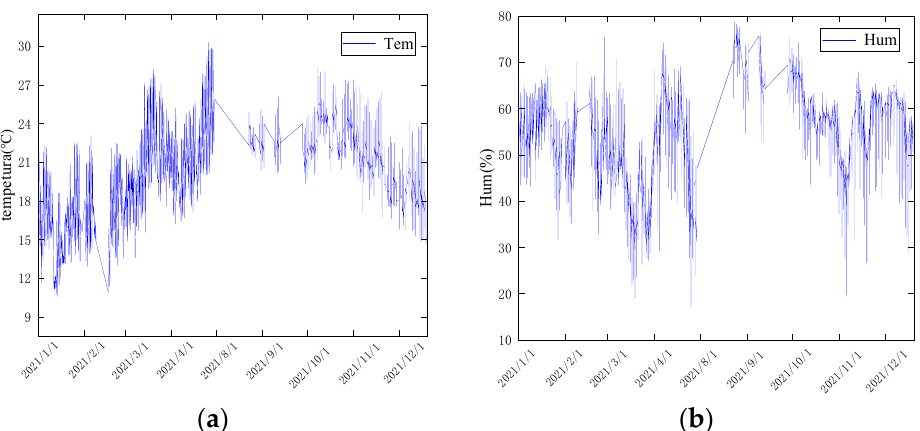
Figure 2. Changes in ambient temperature and humidity: ( a ) indoor temperature; ( b ) indoor humid-